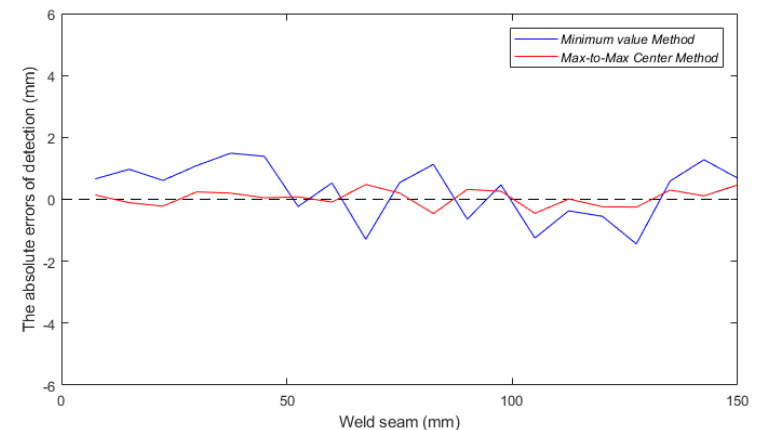
Figure 17. The errors of detection in the experiments. Table 7. Comparison of detection errors from different determination methods.